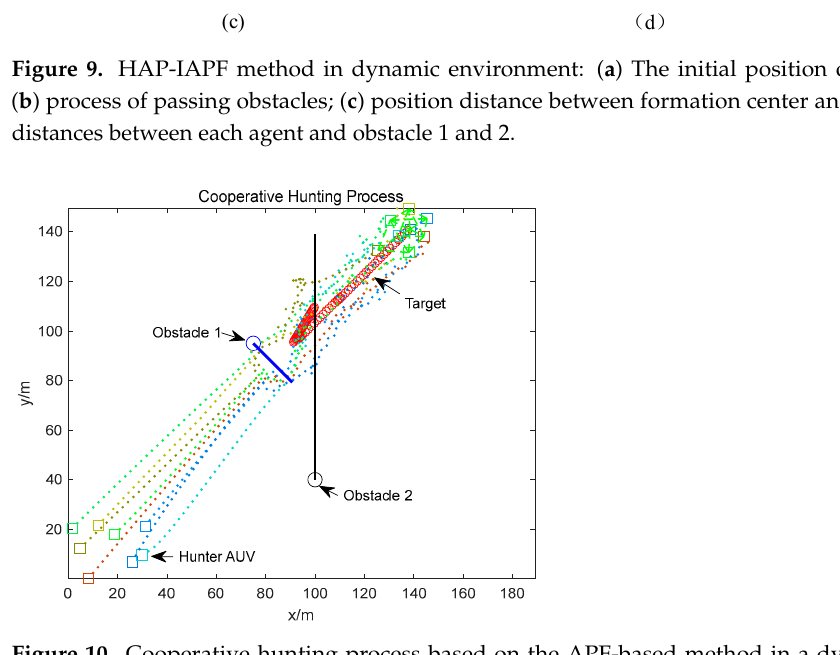
Figure 10. Cooperative hunting process based on the APF-based method in a dynamic obstacle en- vironment.